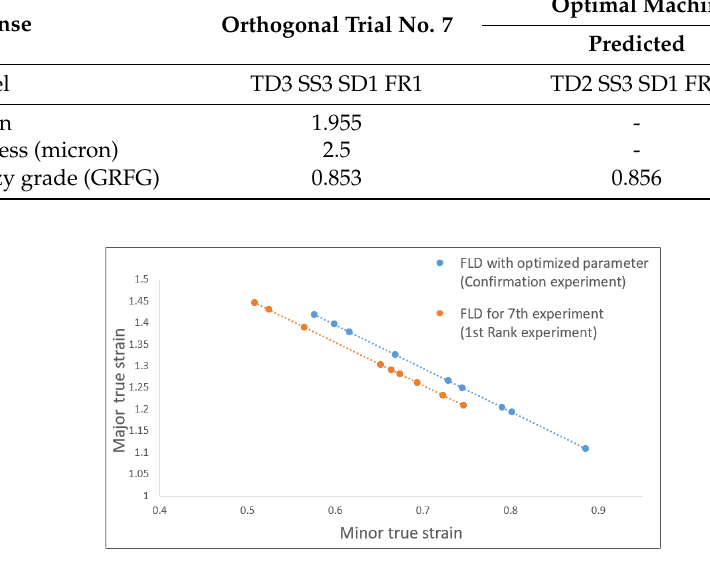
Figure 10. FFLD for first rank and confirmation experiment .